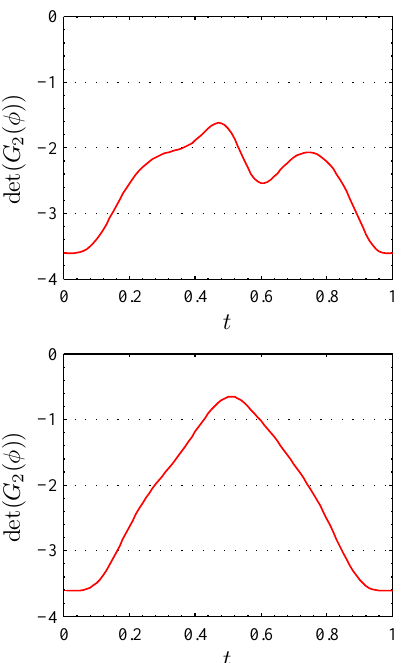
Figure 9. Determinant det( G 2 ( φ )): egalitarian solution (top) and prioritarian solution (bottom).